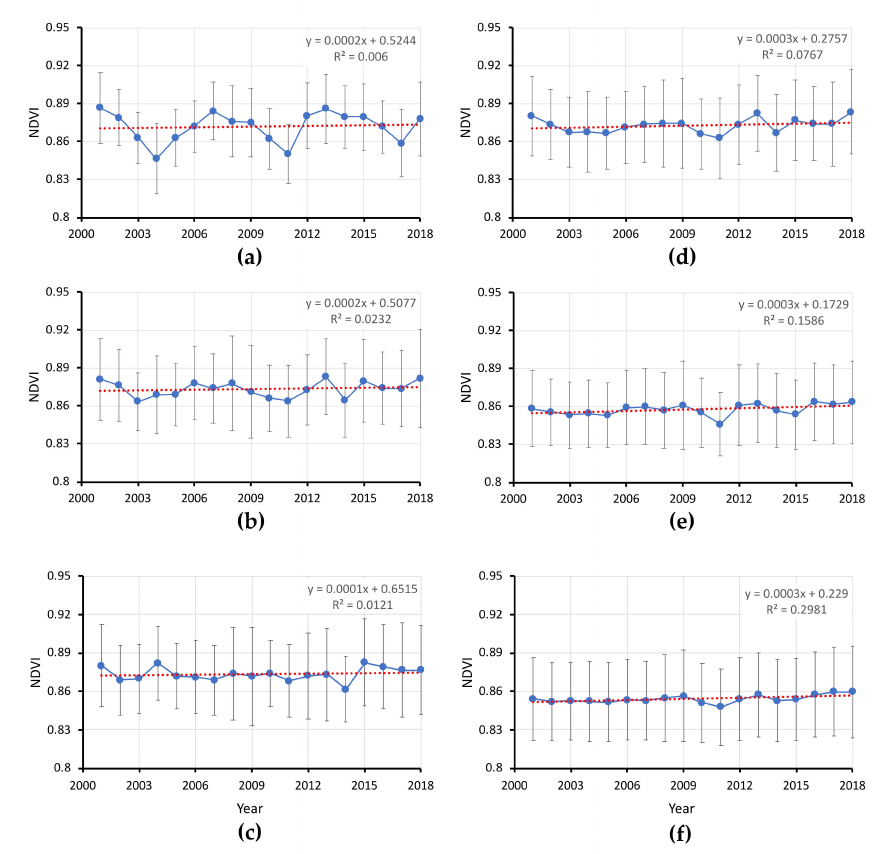
Figure 5. Time series of MODIS NDVI averaged over the study ( a ) Site 1, ( b ) Site 2 and ( c ) Site 3, and also in ( d ) the Sierra Madre, ( e ) Cordillera, and ( f ) the rest of